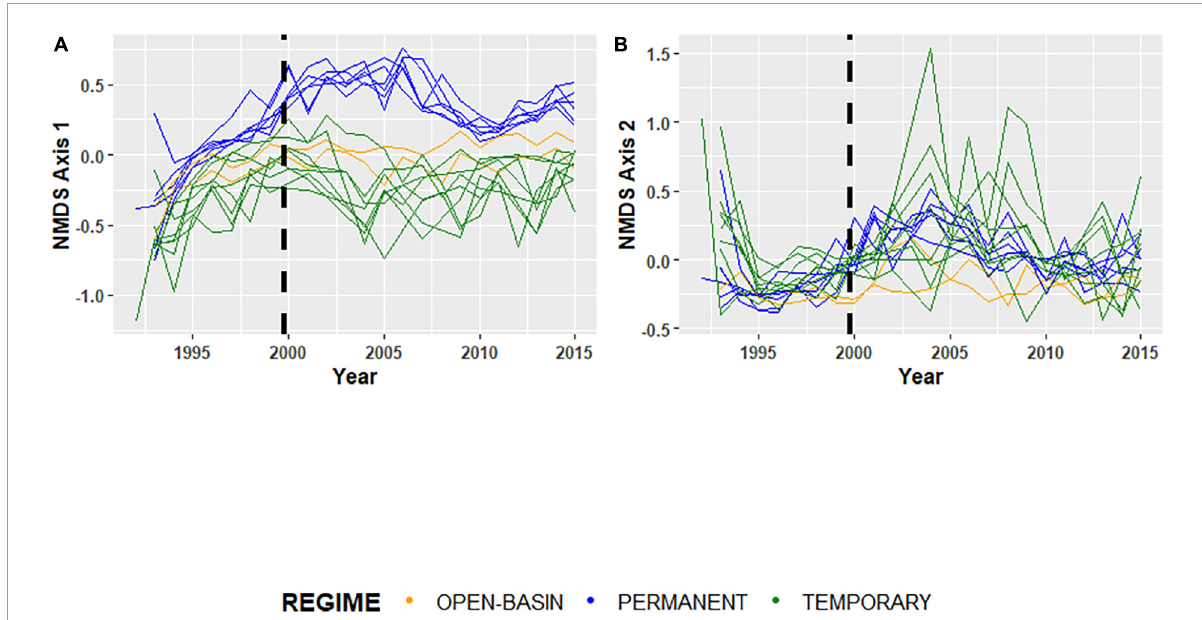
FIGURE3 (A) Sørensen dissimilarity based NMDS axis 1 and (B) Sørensen dissimilarity based NMDS axis 2 scored based on invertebrate taxon presence-absences (Sørensen) for 16 Cottonwood Lake study area wetlands sampled from 1992 to 2015. For each plot, green lines represent temporarily ponded wetlands (T wetlands), blue lines represent permanently ponded wetlands with closed basins (P wetlands), and orange lines represent permanently ponded wetlands with open basins (OB wetland). The black dashed lines indicate the transition for the “filling